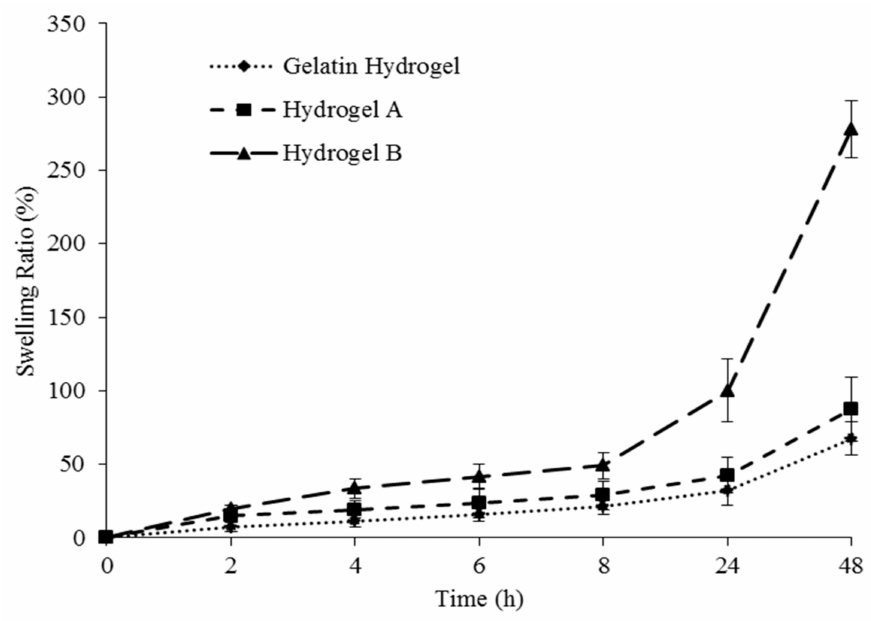
Figure 6. Swelling behavior of different